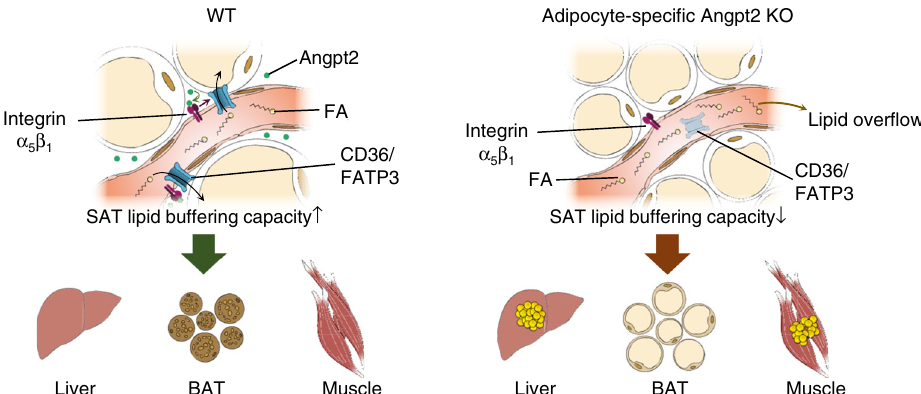
Fig. 10 Endothelial-to-adipocyte fatty acid transport determines metabolic health. Schematic diagram depicting Angpt2 produced from adipocytes could regulate endothelial FA transport via CD36 and FATP3 through integrin α 5 β 1 signaling to accumulate FAs toward SAT. This process prevents ectopic fat accumulation into endocrine organs, and thus prevents